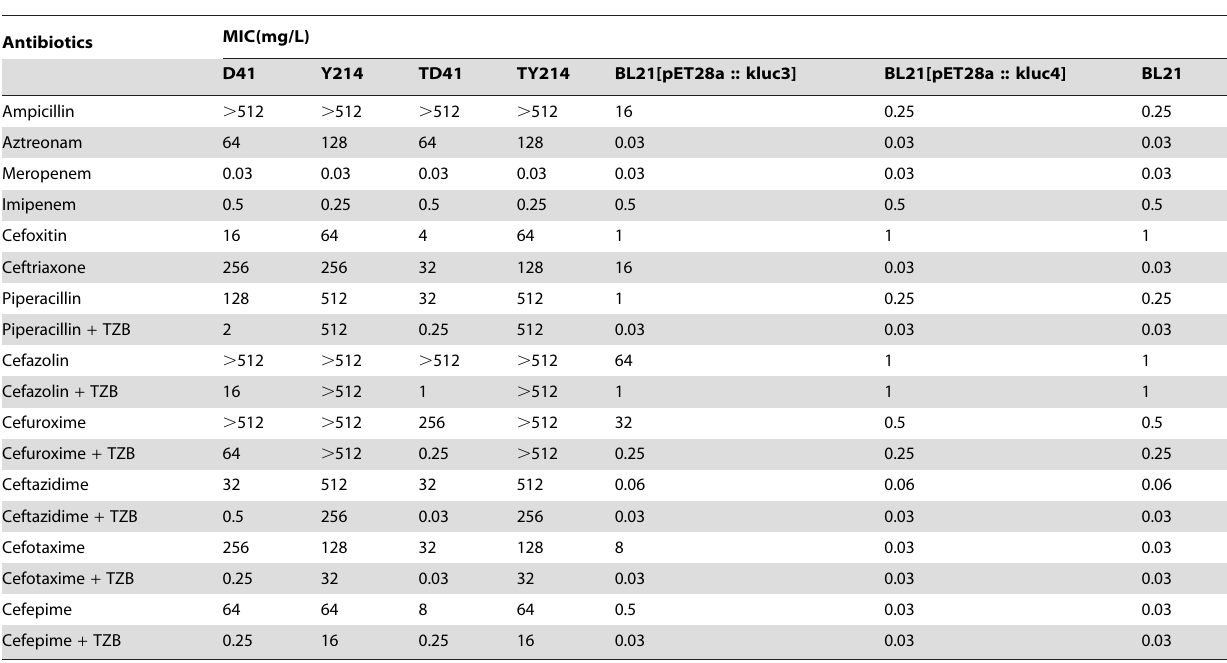
Table 3. MICs of 18 b -lactams or antimicrobial drug complex for donors, transconjugants, transformants and the recipient control